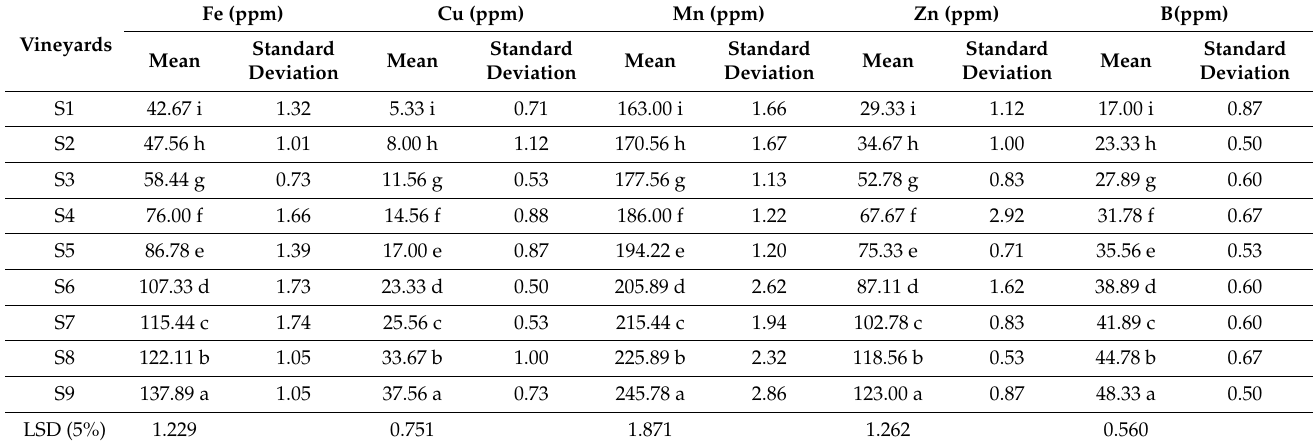
* Different letters indicate that means are significantly different from each other ( p < 0.05).